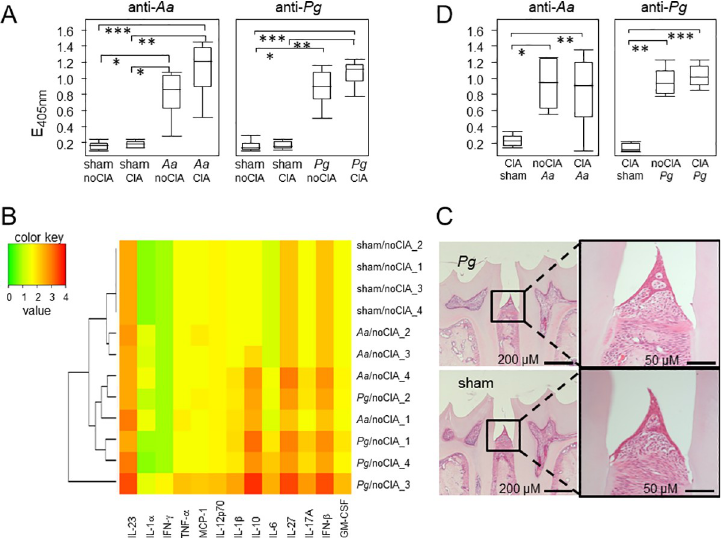
Fig 2. Oral inoculation with pathobionts led to systemic immune responses. (A) shows increased titers of antibodies against Aa (left) and Pg (right) in mice that were either sham treated (n = 7 for all sham groups) or orally inoculated with pathobionts (n = 8 for both Aa groups, n = 8 for Pg /noCIA and n = 9 for Pg /CIA). Statistical significance was calculated via Kruskal-Wallis test with post-tests and resulted in a p-value < 0.0001. Differences between the individual groups are indicated by asterisks. � p-value < 0.05, �� p-value < 0.01, ��� p-value < 0.001. (B) The heat map summarizes the systemic expression levels of inflammatory cytokines (listed below the heat map) on day 74. The color key is shown on the left, individual animals are listed on the right and the dendrogram visualizes the connectedness between animals. Only n = 4 per group were analyzed. (C) shows examples of HE stained thin sections of jaws from mice that were either inoculated with Pg (upper panels) or sham treated (lower panels). (D) shows increased titers of antibodies against Aa (left) and Pg (right) in mice that were induced for CIA before PD (n = 8 for all groups). Statistical significance was calculated via Kruskal-Wallis test with post-tests and resulted in p-values = 0.0023 for anti- Aa and p = 0.0004 for anti- Pg . Differences between the individual groups are indicated by asterisks. � p- value < 0.05, �� p-value < 0.01, ��� p-value < 0.001. Note that the sham/noCIA group is depicted in